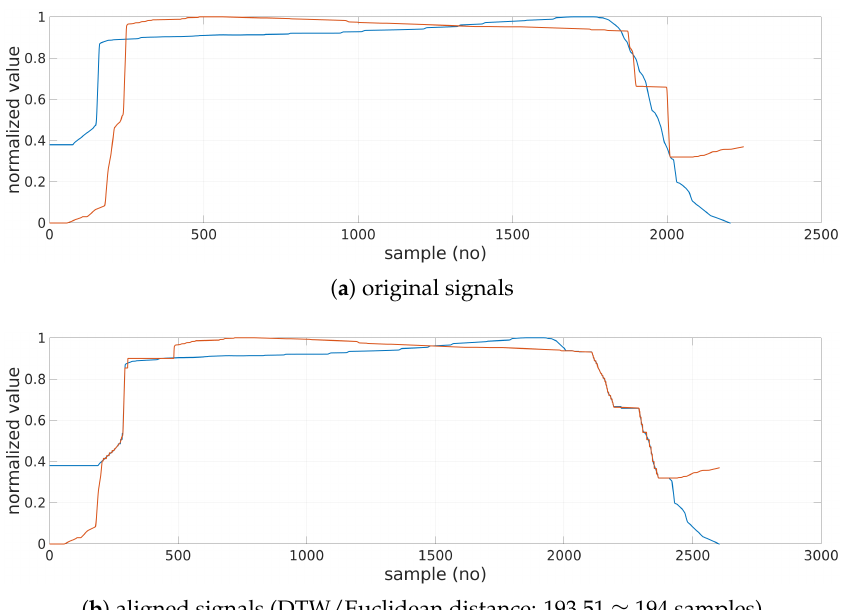
Figure 6. Model (orange) and examined (blue) characters ( a ) before DTW and ( b ) after DTW.